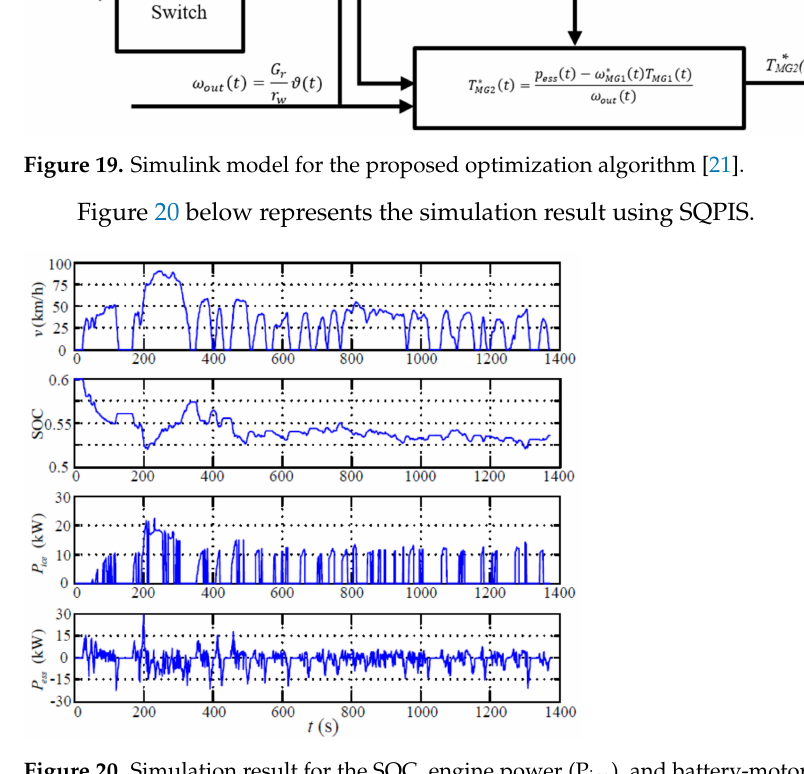
Figure 20. Simulation result for the SOC, engine power (P ice ), and battery-motor system power (P ess ) at different speeds values ( ν )